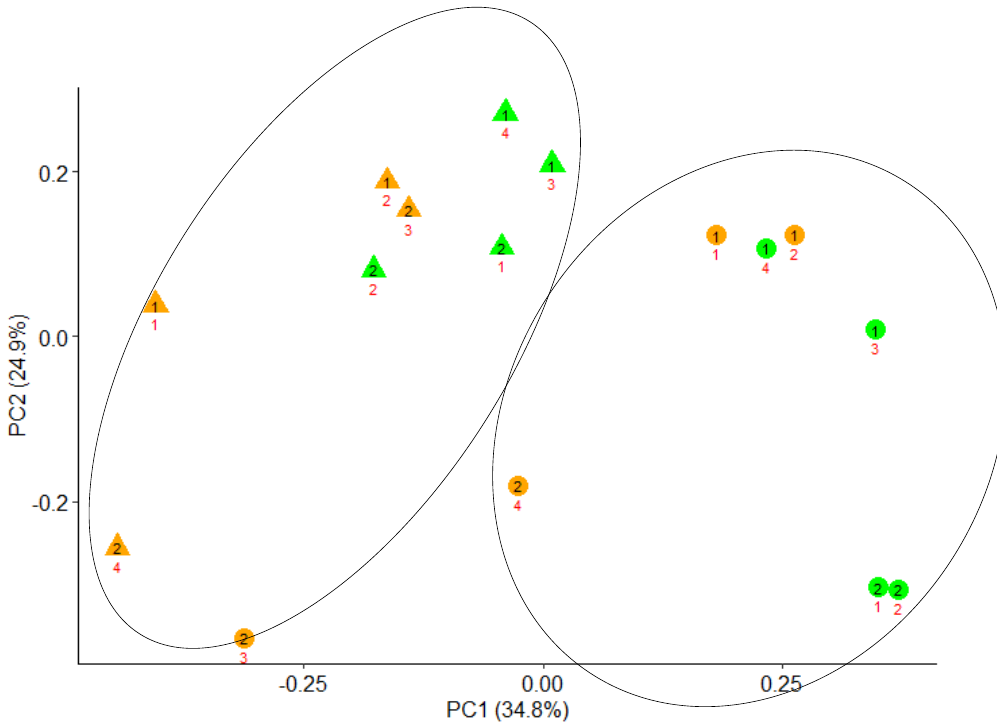
Figure 1. Principal coordinate analysis (PCoA) plot (Bray–Curtis dissimilarities) of the automated ribosomal intergenic spacer analysis (ARISA) profiles from digesta of Rusitec fermenters fed either a mixed diet (orange) or a diet containing crude olive cake (green) replacing 33% of the forage. Circles and triangles correspond to liquid and solid digesta, respectively. Numbers in black (1 and 2) relate to incubation run, and those in red (1 to 4) to a Rusitec